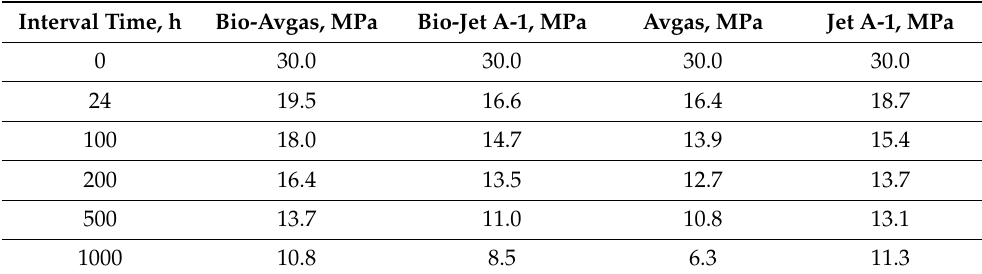
Table 2. Experimental contact pressure values of the AFM gasket for different fuels. Interval Time, h Bio-Avgas,